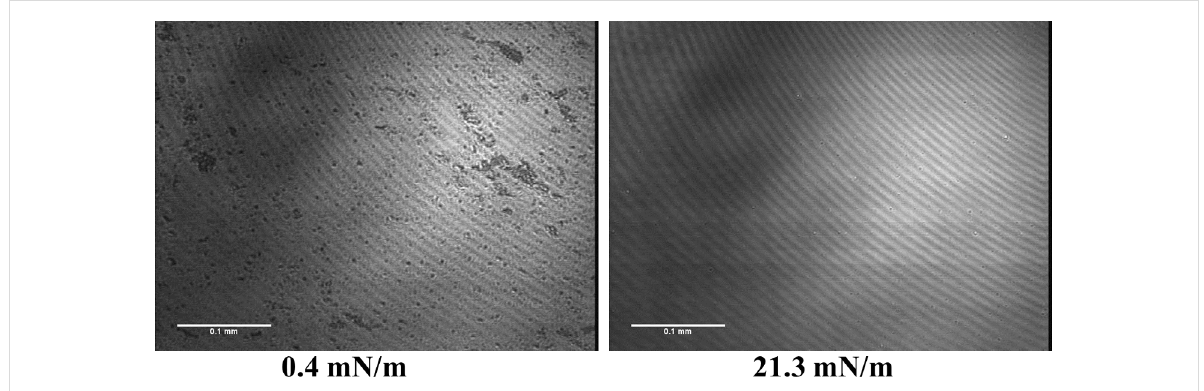
Figure 3: BAM pictures obtained at pH 4 without calcium (citric buffer with 150 mM NaCl and 1 mM EDTA) at selected surface pressures (indicated).